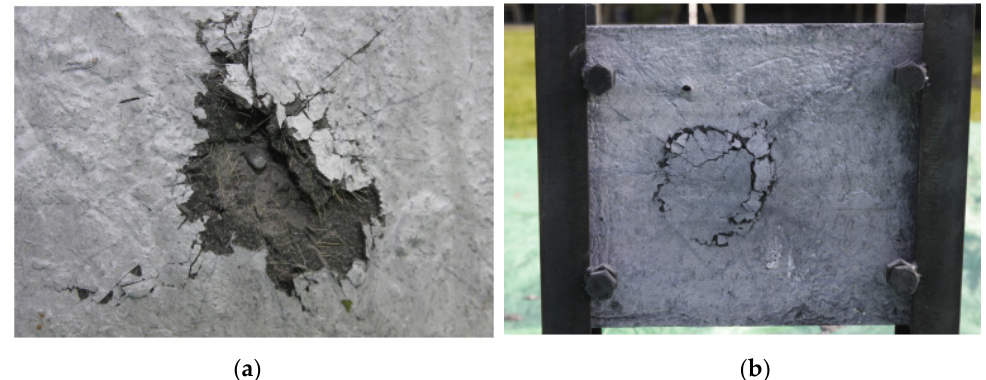
Figure 7. Effect of a projectile impact on a 50 mm UHPFRC slab: ( a ) perforation limit and ( b ) borders of the crater on back side ([61]–Elsevier Copyright.s)